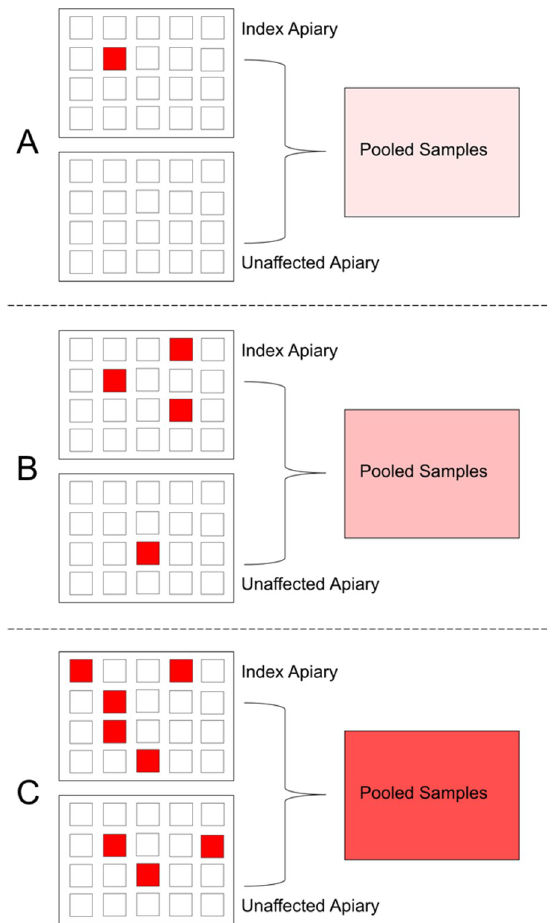
Fig 5. Conceptual representation of the detection of a spore “signal” in pooled, apiary-level honey samples. The corresponding apiaries the pooled samples are derived from are indicated by letters for operations A, B, and C. Small boxes within an apiary represent individual bee hives, and red boxes represent those hives heavily contaminated with spores of P . larvae . A lighter “signal” (light pink/red) in the pooled samples reflects operations with very little contamination in individual hives, whereas higher concentrations of spores (stronger “signal”–red) in pooled samples correspond to more widespread and/or chronic contamination. Index and unaffected apiaries are used in this theoretical